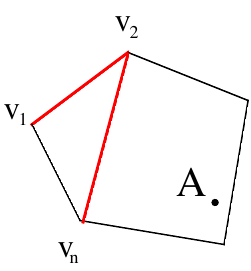
Figure 3 . A polygon. While the line segment ( V n V 2 ) is not an edge of the polygon, ( V 1 V 2 ) is. ( V i ; V i ) to be an edge, we must 1 2